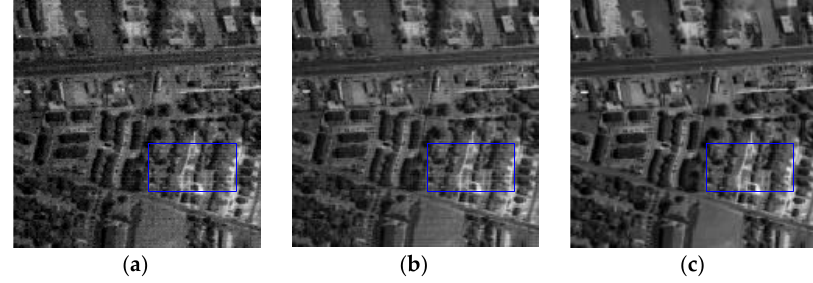
Figure 23. Restored results in Urban data: ( a ) Original band 133; ( b ) SNT-DIS; ( c ) Our method.